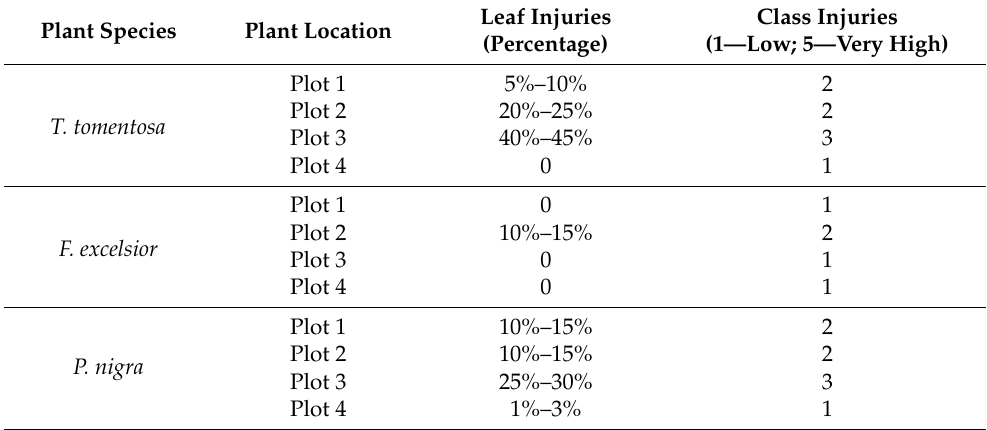
Table 5. Leaf traits at August 2020—6 years after transplantation into the urban environment.